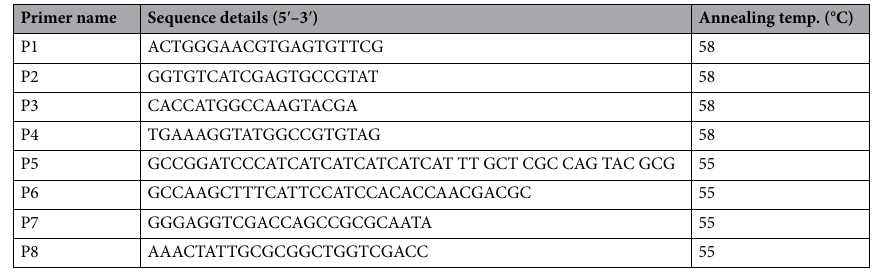
Table 3. Primer used for this